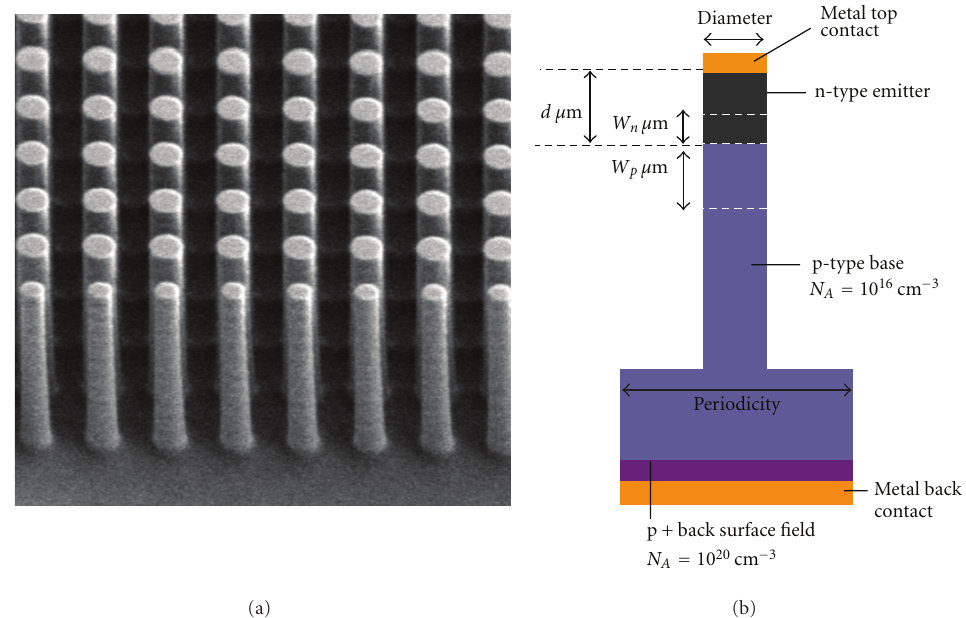
Figure 18: (a) SEM image of a Si nanopillar pattern used for simulating PCE analysis. Pillar parameters are diameter = 200 nm, pitch = 400nm, and height = 1000 nm; (b) crossectional schematic of axial junction. (Reprinted with permission from [8]. [2010] IEEE.)